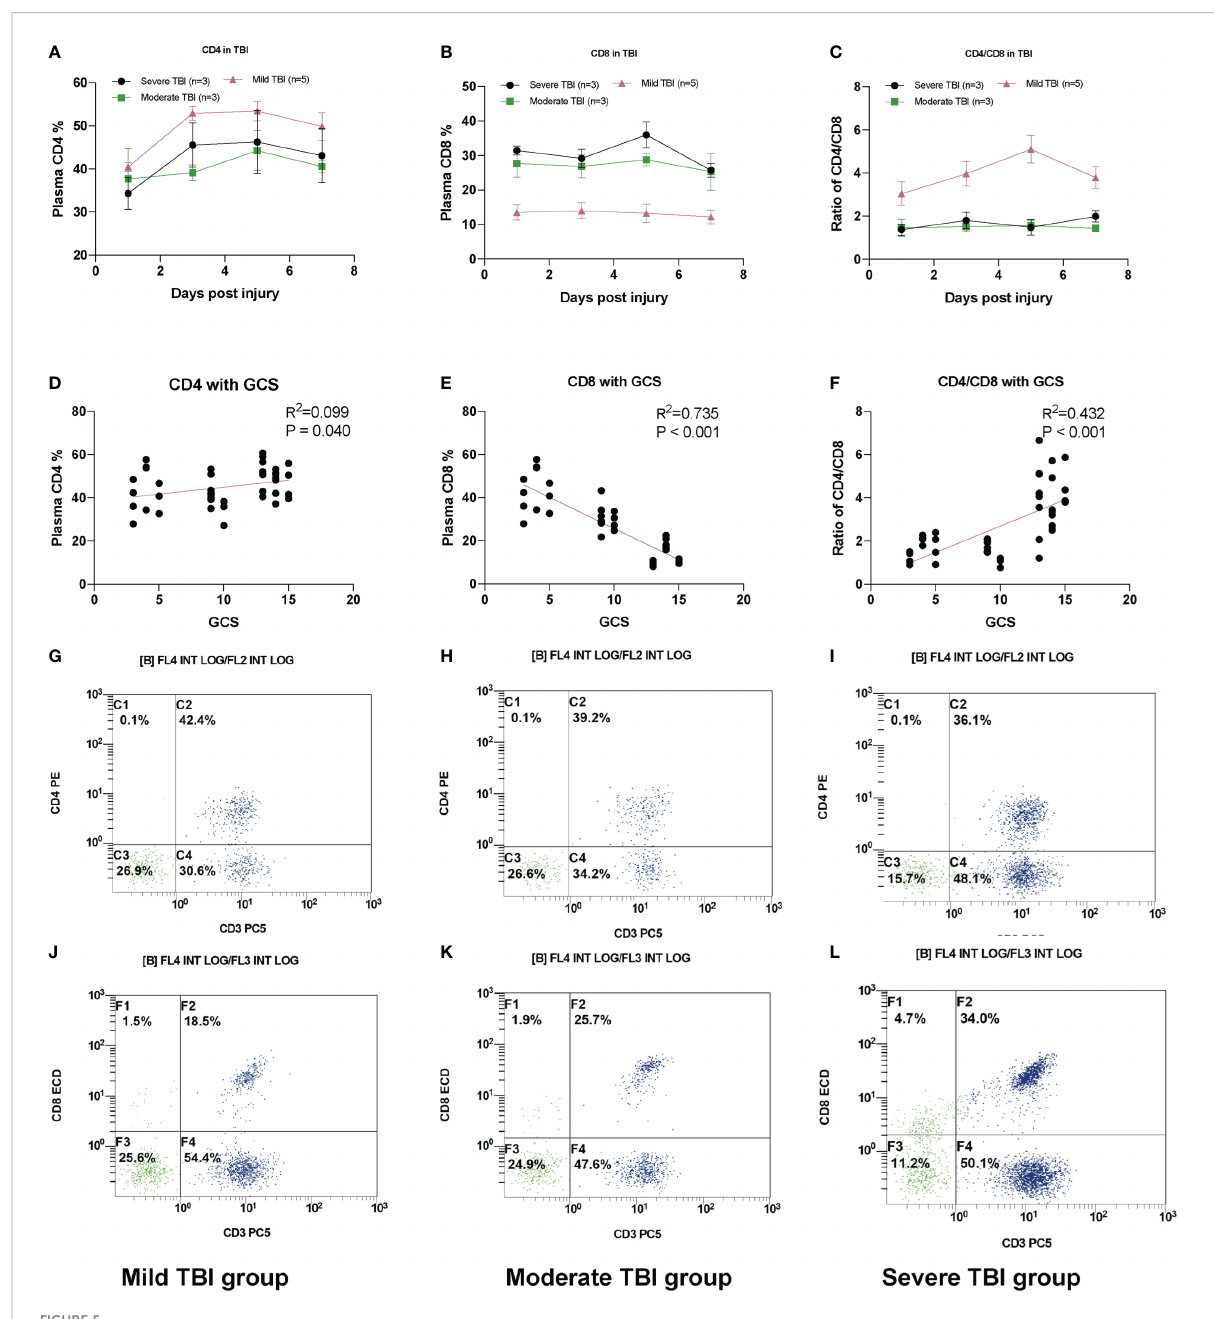
FIGURE 5 Plasma CD8+ T-cell increases in TBI. (A) The relative plasma CD4 percentage (re fl ected by CD3+ CD4+) in TBI groups. (B) The relative plasma CD8 percentage (re fl ected by CD3+ CD8+) in TBI groups. (C) The ratio of CD4/CD8 in TBI groups. (D) The scatter plot of plasma CD4 T% with GCS. (E) The scatter plot of plasma CD8 T% with GCS. (F) The scatter plot of CD4/CD8 with GCS. (G) The representative FACS image of CD4 (re fl ected by CD3+ CD4+) in severe TBI groups. (H) Moderate TBI and (I) mild TBI. The representative FACS image of CD8 (re fl ected by CD3+ CD8+) in (J) mild TBI groups. (K) Moderate TBI and (L) severe TBI. N = 3 – 5 in each